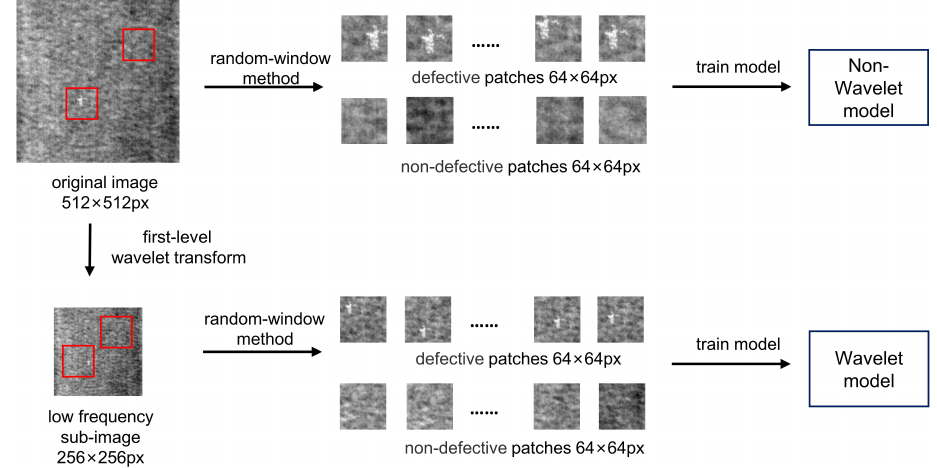
Figure 4. The process of this method in the model training phase. The original image and wavelet image are divided into patches and sent to the network for training